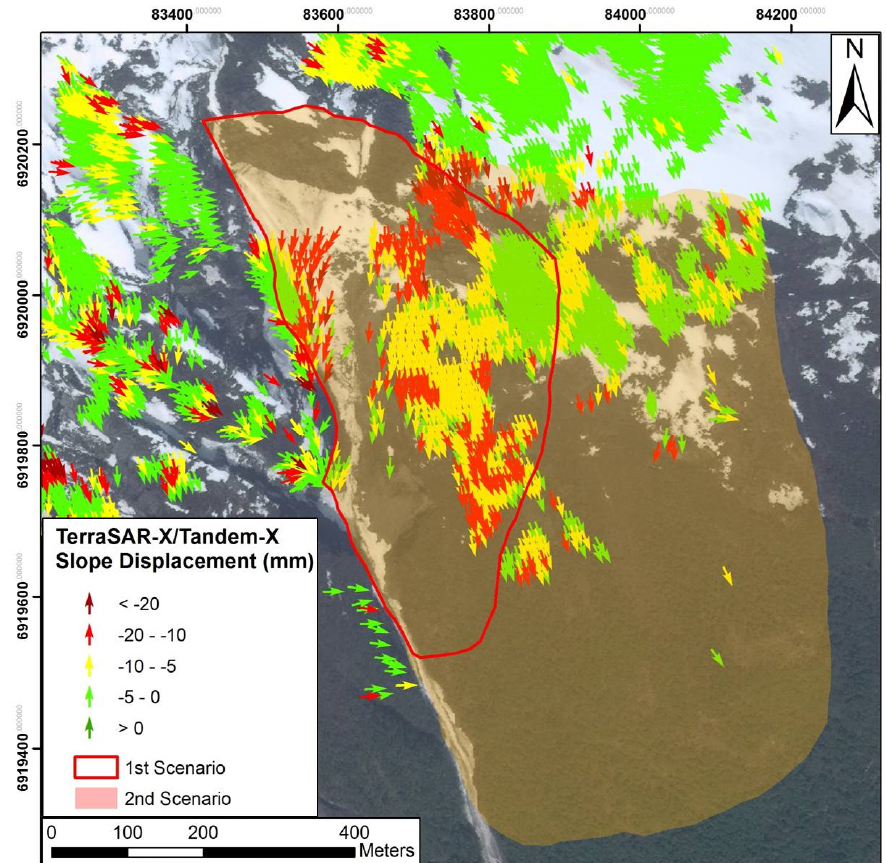
Figure 14. Slope displacements registered by TerraSAR-X/Tandem-X in 2010. Arrows are oriented along the downslope direction. The red line corresponds to the landslide limit in the most dangerous scenario.